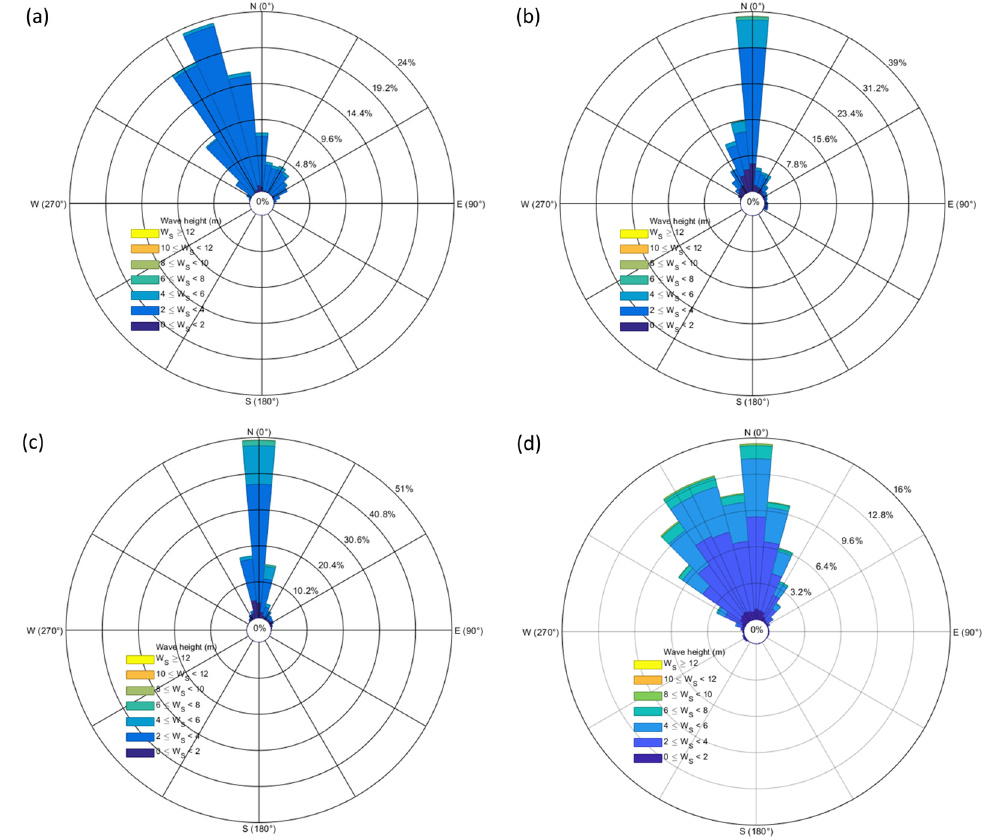
Figure 8. Mean wave direction for the control points located close to the ports for the far future period (2081–2099) for the ( a ) Aveiro lagoon, ( b ) Tagus estuary, ( c ) Ria de Vigo, and ( d ) the NWIP coast near A Coruña Outer Port. Table 5. Wave height ( Hs ), peak period ( Tp ), and mean wave direction ( Dm ) for each region contiguous to the ports under study, climate period and return period.